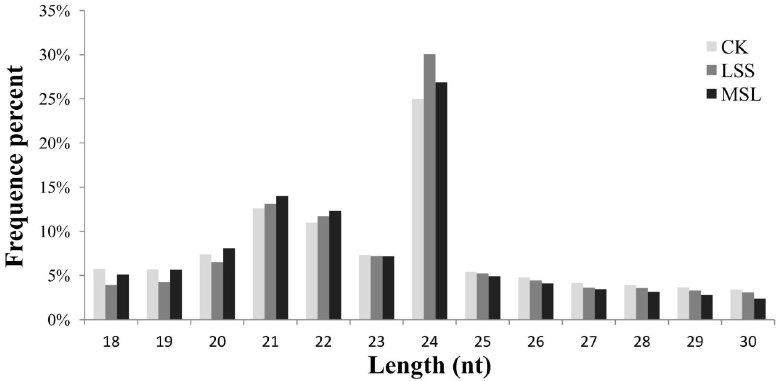
Figure 1. Small RNA length distribution in Ulmus pumila L. . CK, without salt stress; LSS, light salt stress for a short time; and MSL, medium ‐ heavy salt stress for a long time.